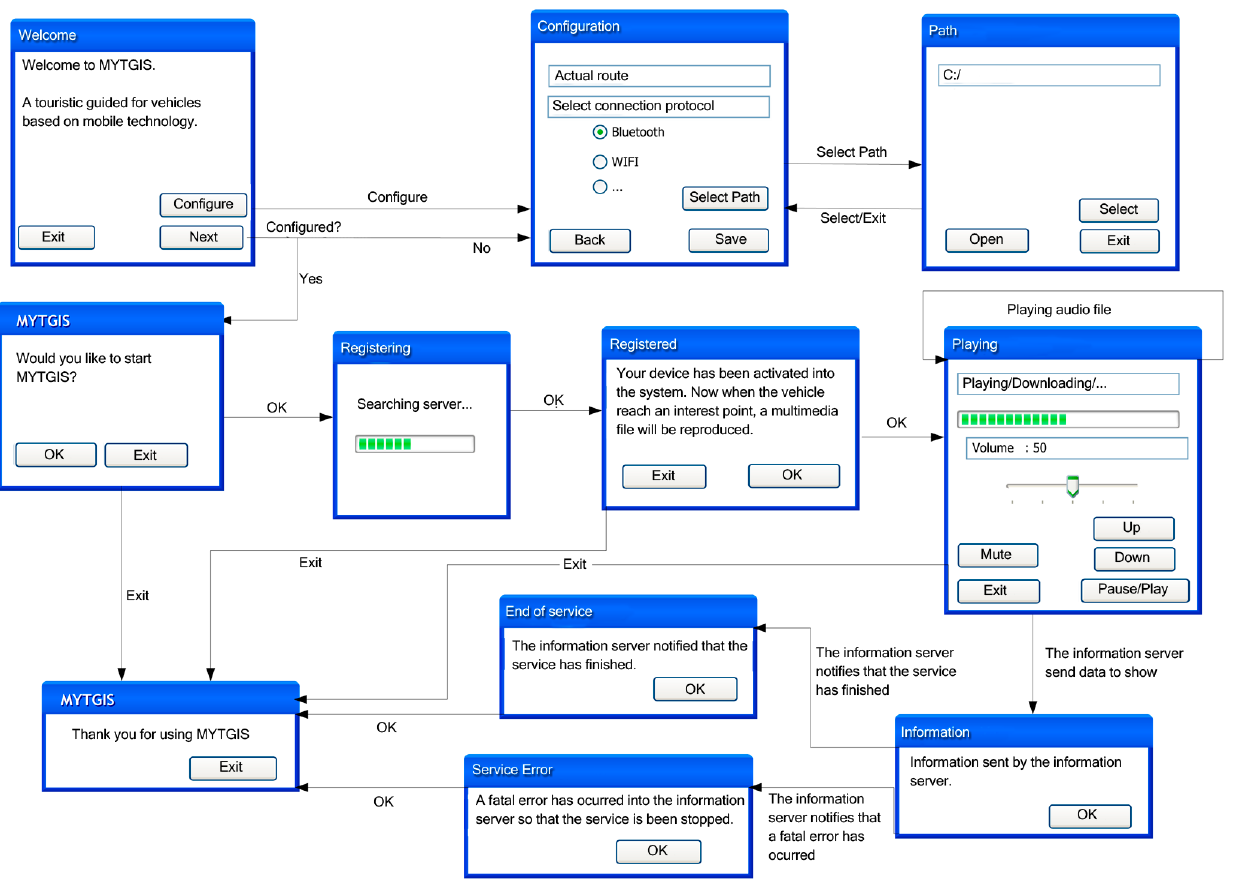
Figure 3. Flow diagram of the Client